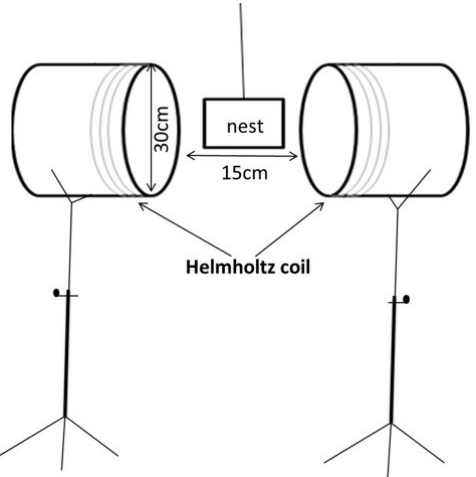
Fig 1 . Representation of the Helmholtz coil apparatus with the variable-length pole, permitting the generation of altered magnetic field, in the region of the wasp nest.